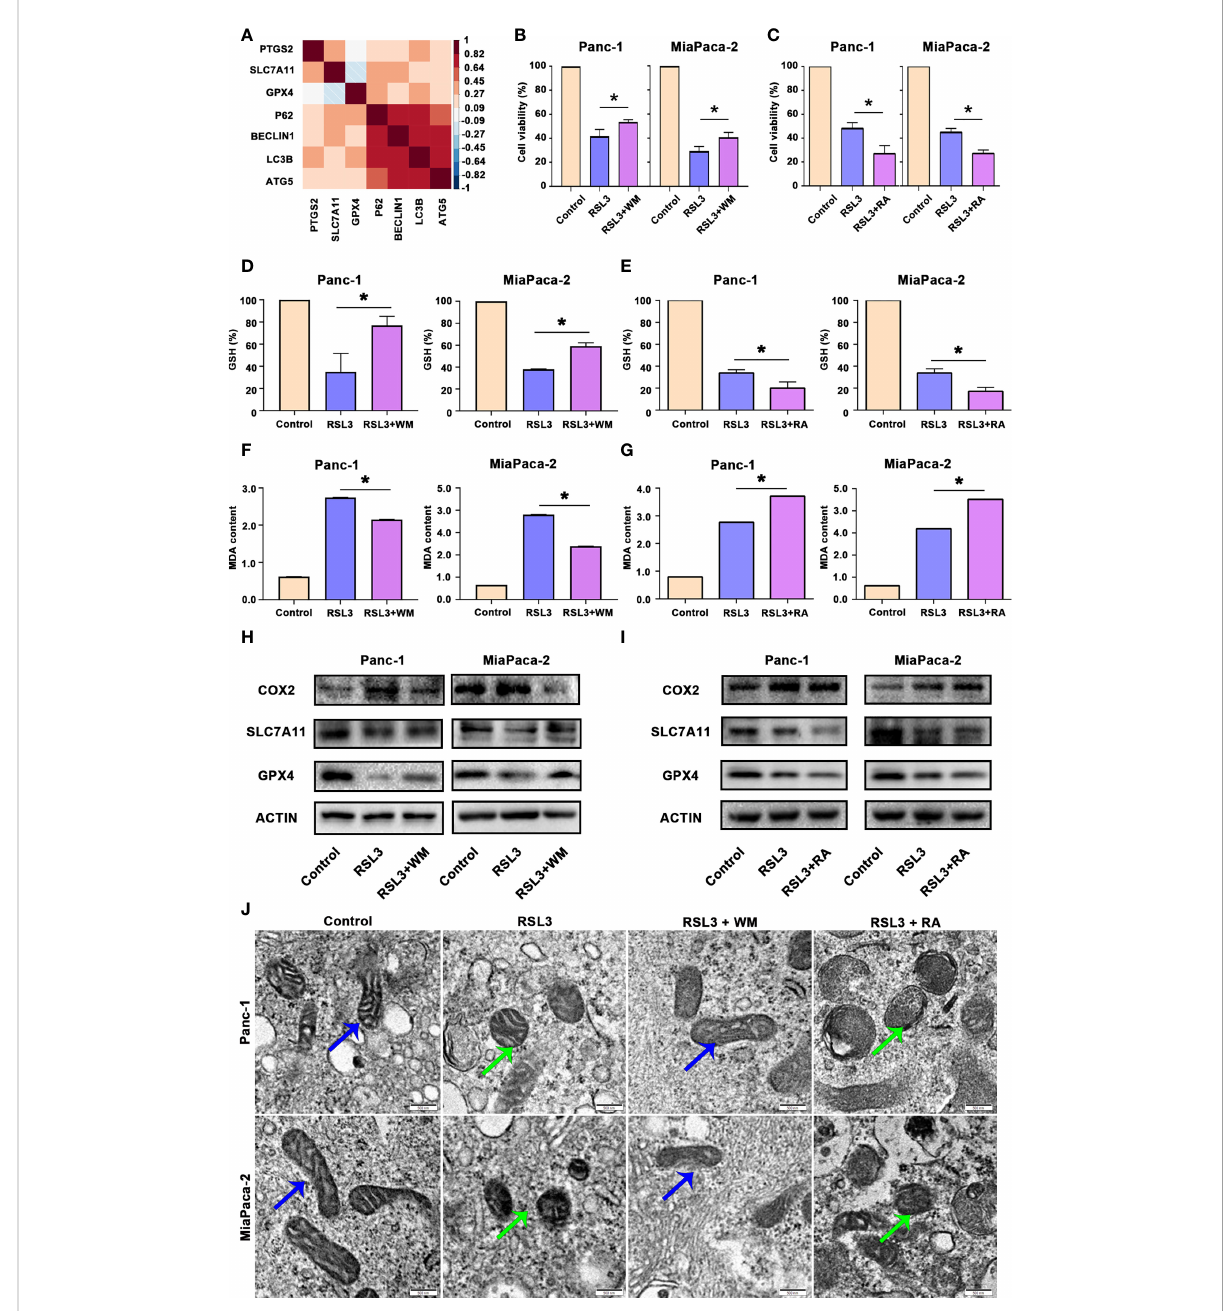
FIGURE 5 Autophagy promoted ferroptosis in pancreatic cancer. (A) Hierarchical clustering results in the TCGA-PAAD cohort of 7 genes involved in ferroptosis and autophagy. Correlation map reporting Spearman correlation values for each comparison. The bar on the left of the map indicates the colour legend of the Pearson correlation values calculated for each pair of genes in the matrix. (B) CCK8 assay showing the viability of Panc-1 and MiaPaCa-2 cells after the control, RSL3 and RSL3 plus wortmannin (WM) treatments for 96 h. (C) CCK8 assay showing the viability of Panc-1 and MiaPaCa-2 cells after the control, RSL3 and RSL3 plus rapamycin (RA) treatments for 96 h. (D, F) The measurement of GSH and MDA concentrations in Panc-1 and MiaPaCa-2 cells after the control, RSL3 and RSL3 plus WM treatments. (E, G) The measurement of GSH and MDA concentrations in Panc-1 and MiaPaCa-2 cells after the control, RSL3 and RSL3 plus RA treatments. (H) Western blotting showing the protein levels of COX2, GPX4 and SLC7A11 in RSL3 in Panc-1 and MiaPaCa-2 cells after the control, RSL3 and RSL3 plus WM treatments. (I) Western blotting showing the protein levels of COX2, GPX4 and SLC7A11 in RSL3 in Panc-1 and MiaPaCa-2 cells after the control, RSL3 and RSL3 plus RA treatments. (J) TEM images showing mitochondria (blue arrows re fl ect normal like and green arrows re fl ect ferroptosis like) in Panc-1 and MiaPaCa-2 cells after the control, RSL3, RSL3 plus WM and RSL3 plus RA treatments. *P < 0.05, scale bar = 500